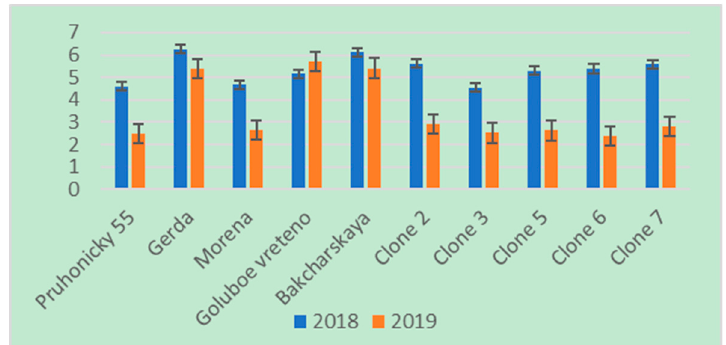
Figure 1. Total polyphenols content (TPC) (polyphenols to gallic acid mg L − 1 ) in fruits of edible honeysuckle cultivars and clones, in the years 2018 and 2019.